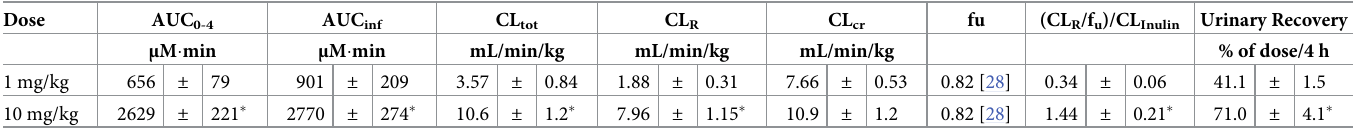
Table 3. Pharmacokinetic parameters of cephalexin in control rats after intravenous administration of cephalexin.